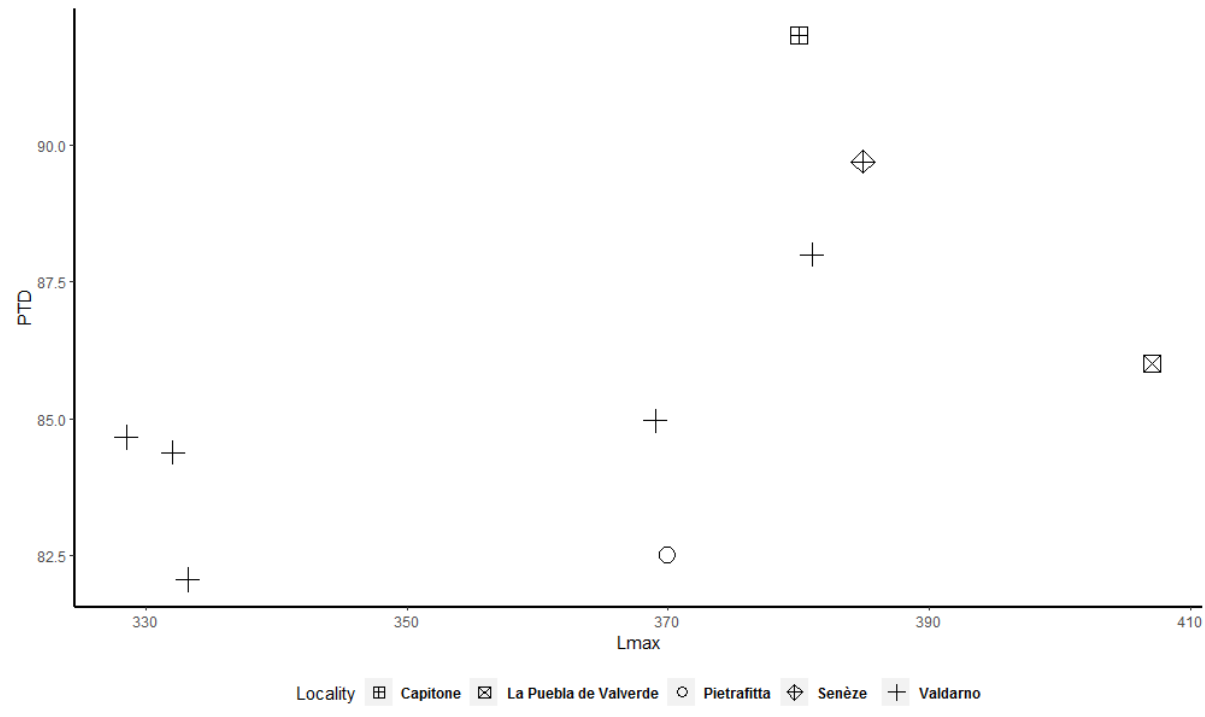
Figure 7. Scatterplot between the maximum length (Lmax) and the proximal transverse diameter (PTD) of the radius.